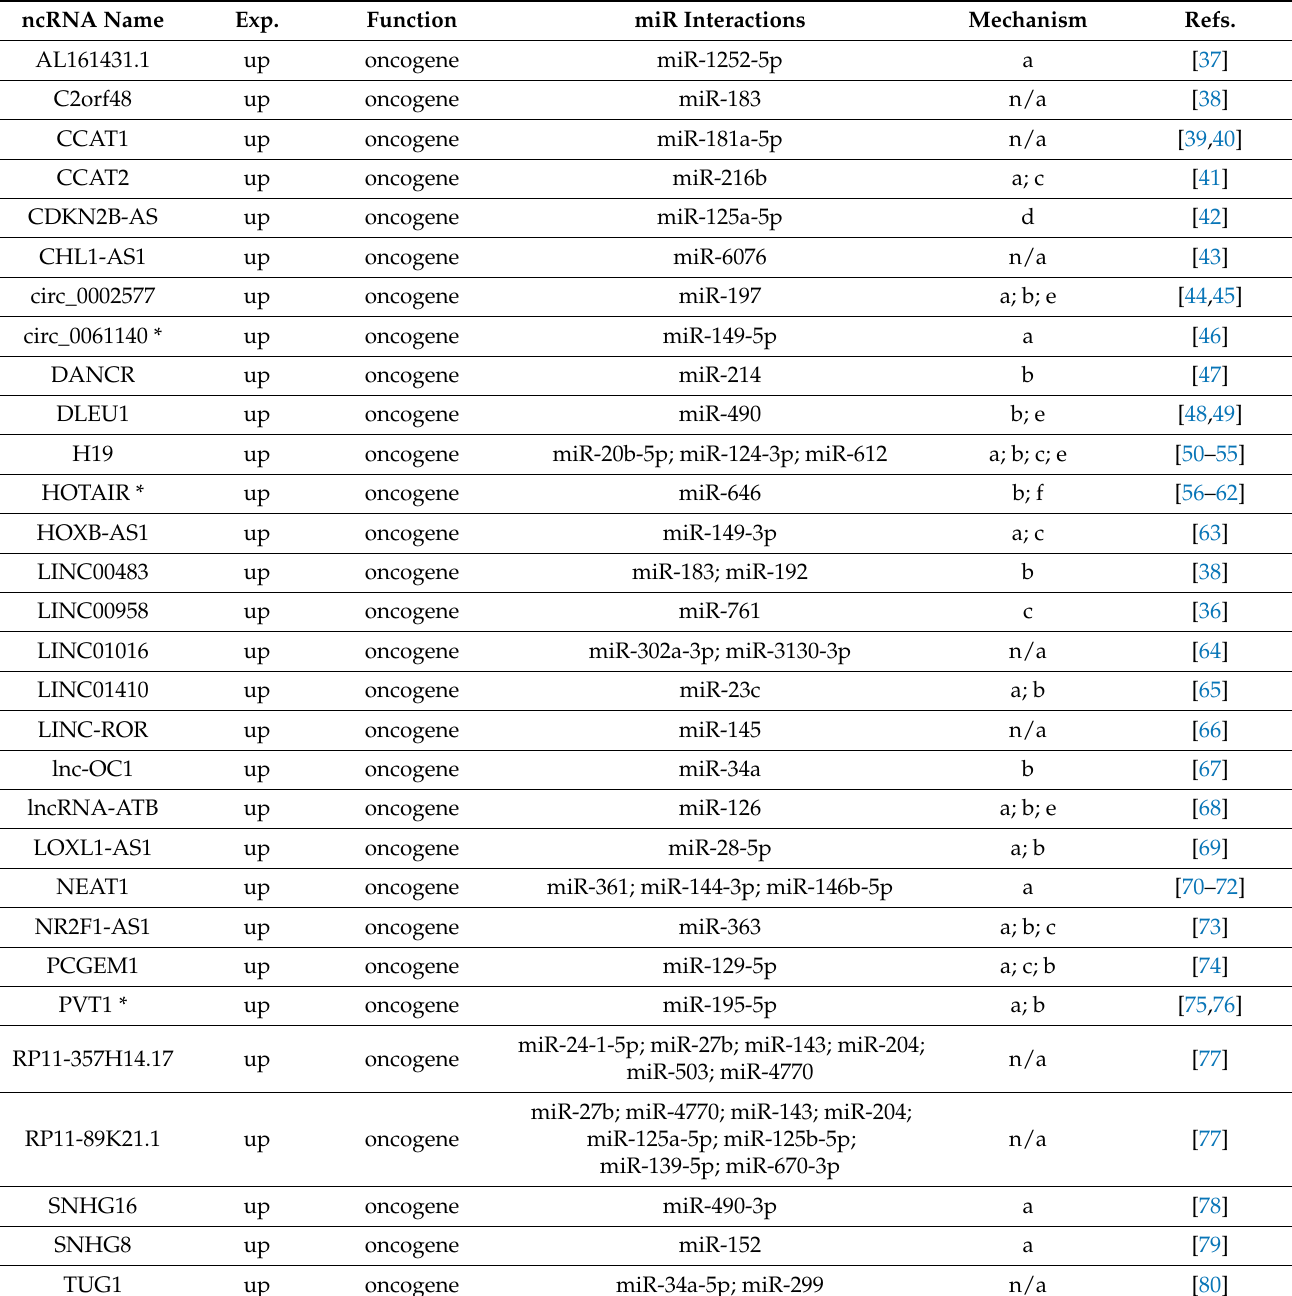
Table 3. A summary of ncRNAs that play a role as oncogenes in EC pathogenesis and for which a functional characterization is